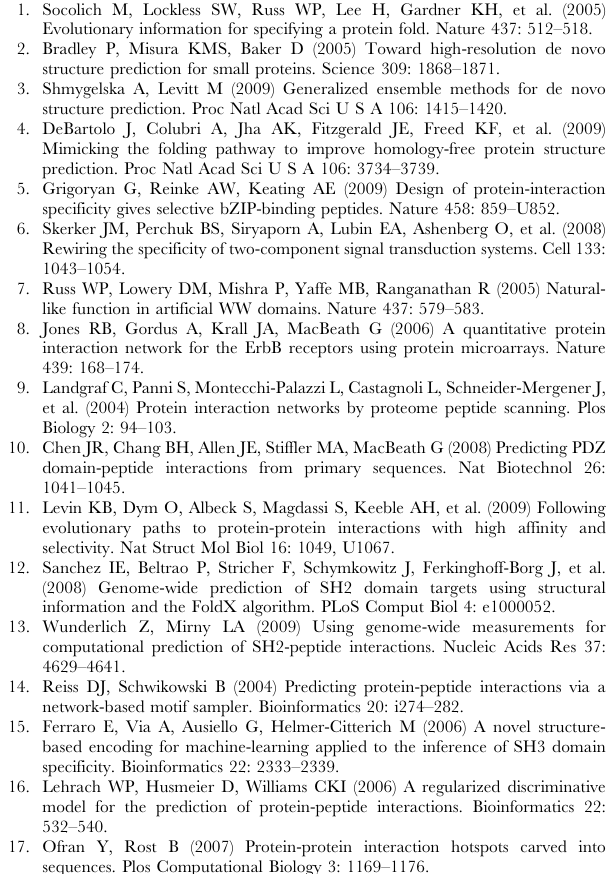
Table S8 Previous computational studies that revealed residues that are under functional constraint.